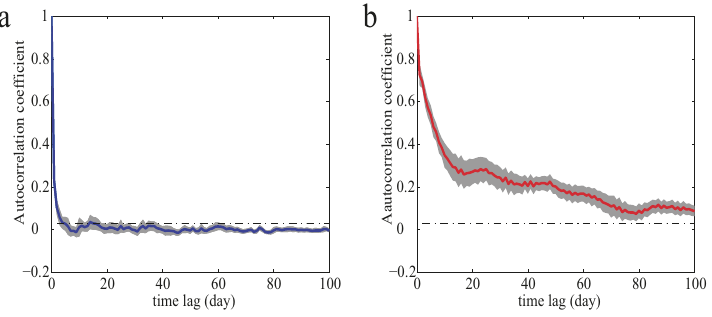
Figure 5. Autocorrelation graphs of ( a ) daily TRMM precipitation (blue) and ( b ) satellite soil moisture (red) during 1998–2009 over sub-region REC (see Figure 1). Blue and red lines are the averages of autocorrelations in REC sub-region with standard deviations indicated by gray areas. Black dash-dot horizontal lines indicate where p = 0.05 using the Student’s t -test.